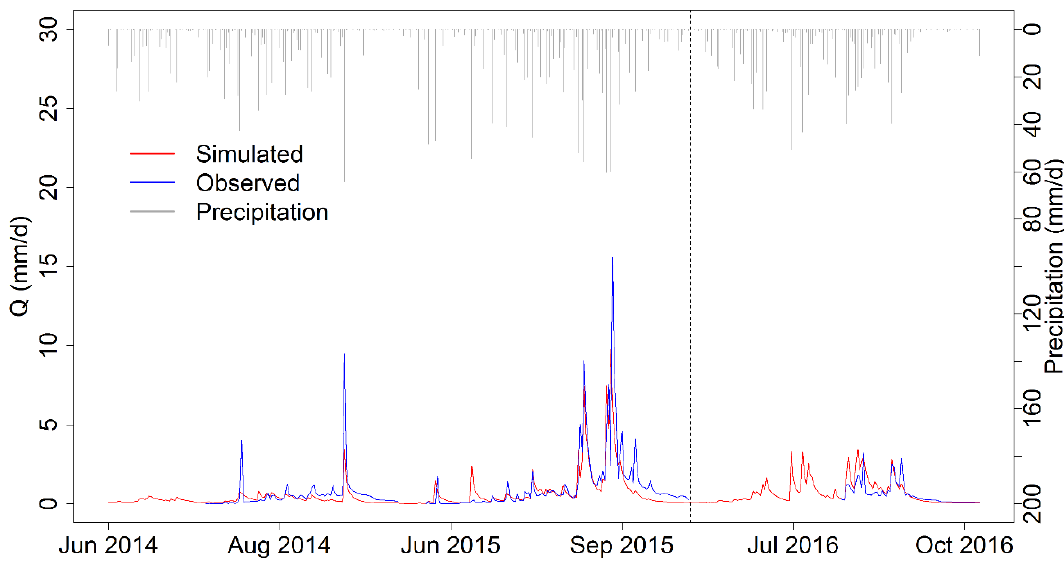
Figure 4. Comparison of simulated discharge using Hamon ETp and observed discharge at the outlet of the Bankandi-Loffing catchment. The vertical dashed line separates the calibration (2014–2015) period from the validation (2016) period. Table 3. Mean annual water balance and the model